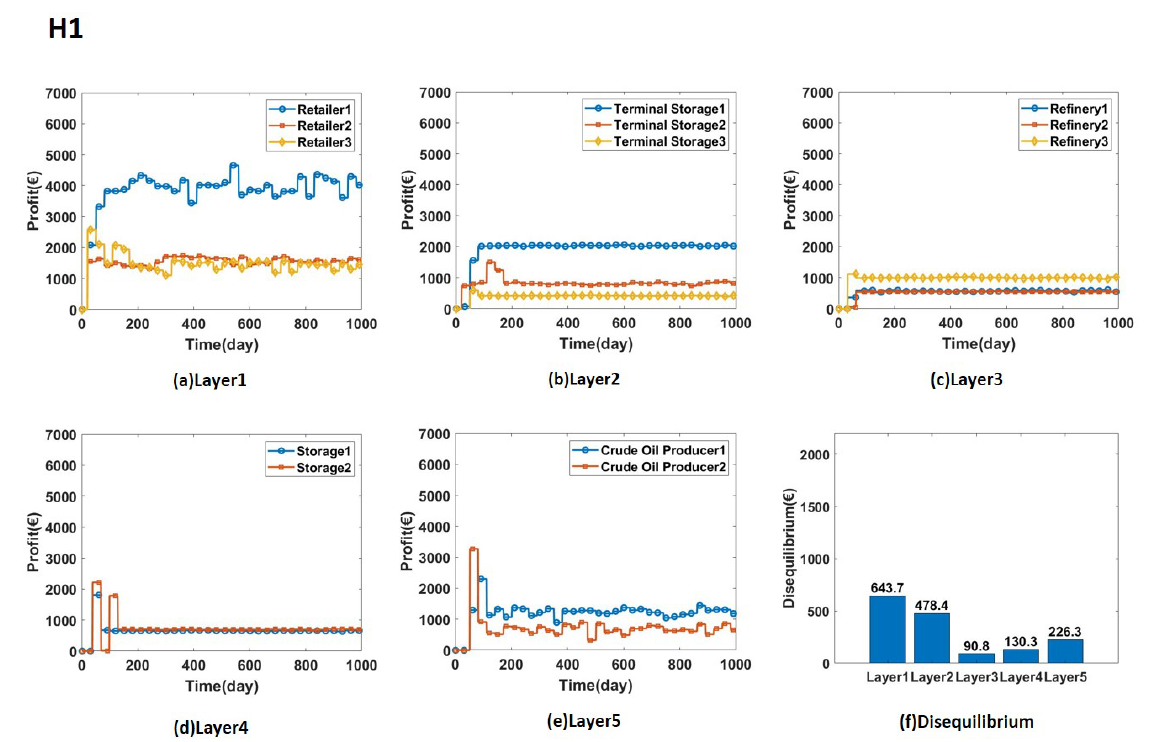
Figure 15. The profit and the disequilibrium of the profit for each layer considering variables of H 1